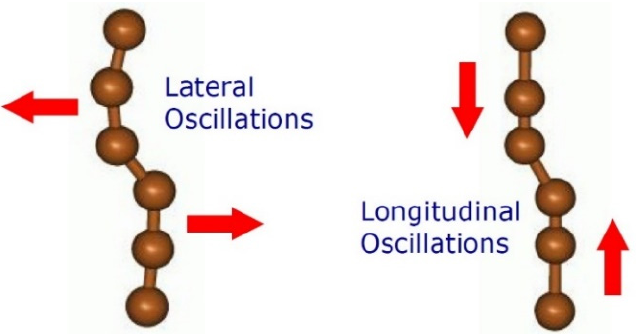
Figure 11. Schematic representation of the lateral and longitudinal oscillations of the sp-hybridized carbon chains.